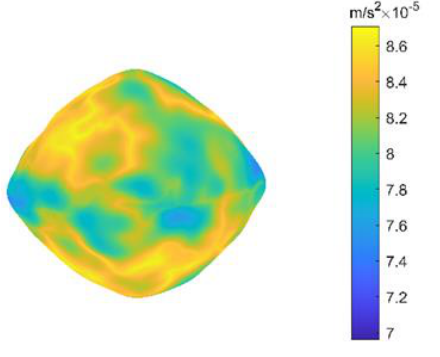
Figure 4. The learned gravity on Bennu’s surface.